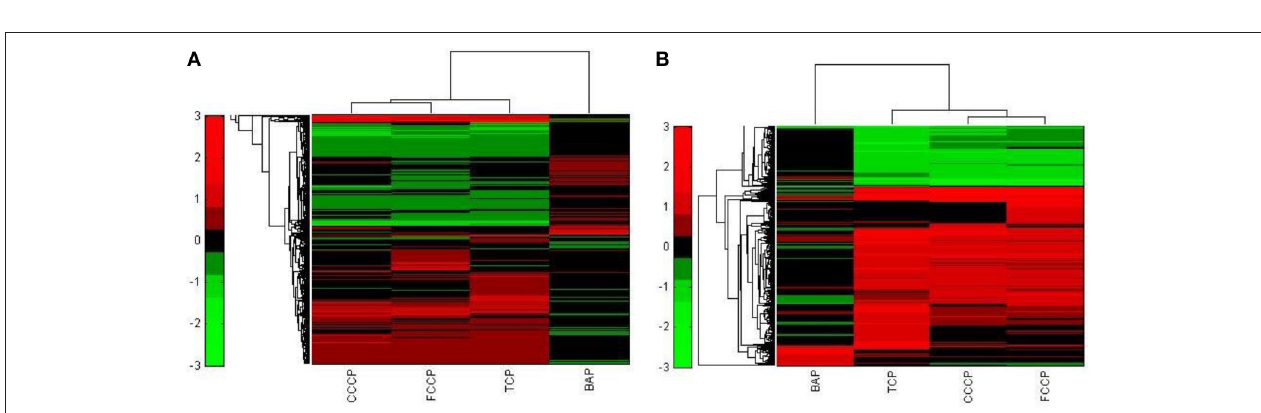
FIGURE 4 | Hierarchical cluster analysis of C3A cells exposed to 3 compounds (FCCP, CCCP, and TCP) with a known uncoupling MoA and BaP). (A) The hierarchical cluster analysis is based on the 5000 most varying genes. (B) The hierarchical cluster analysis is based on the significantly regulated genes (|M| >